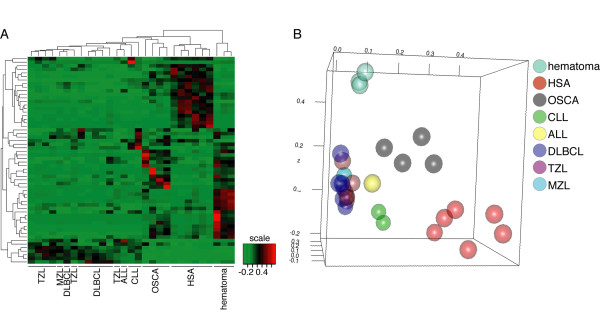
Hemangiosarcoma is distinguishable from both non-malignant and other malignant tumors. (A). Hierarchical clustering of tumor samples or non-malignant lesions (hematoma) from golden retrievers. Tumor samples were from osteosarcoma cell lines (OSCA), primary leukemia (ALL-Acute lymphoblastic leukemia or CLL-Chronic lymphocytic leukemia) or non-Hodgkin lymphoma (diffuse large B-cell lymphoma, marginal zone lymphoma, or T-zone lymphoma) cells, or hemangiosarcoma cell lines (HSA). Hierarchical clustering was done using the restricted probe list from Table S2. (B) Principal component analysis (PCA) of tumor samples and non-malignant lesions described in (A), except analysis was done using all data points.